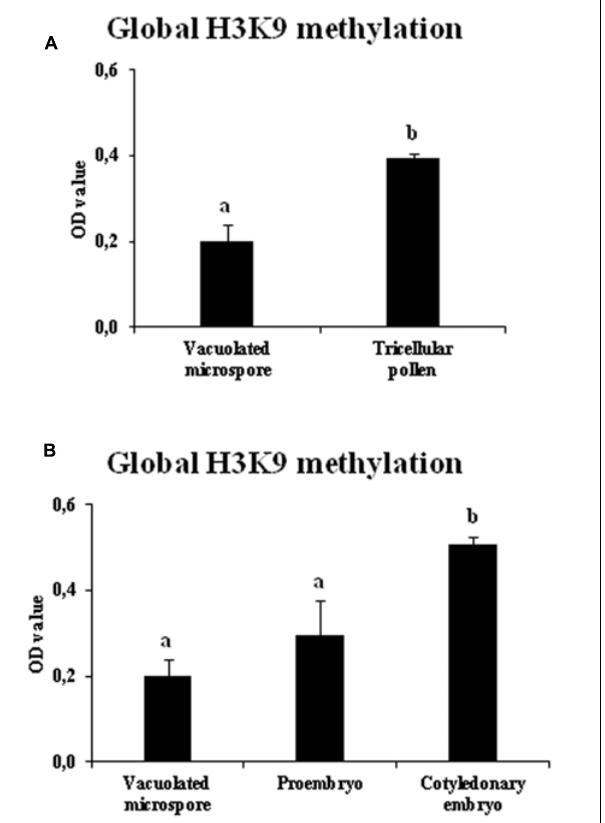
FIGURE 5 | Quantification of H3K9me2 immunofluorescence signal intensity during pollen development and microspore embryogenesis in Hordeum vulgare. Histograms represent the level of immunofluorescence intensity, in arbitrary units, as measured by ImageJ software tools over confocal maximum projections images, in different stages of the two microspore pathways, gametophytic development ( A : vacuolated microspore and tricellular pollen), and microspore embryogenesis ( B : vacuolated microspore, proembryo and coleoptilar embryo). Columns represent mean fluorescence intensity ( ± SEM). Different letters indicate significant differences according to ANOVA and Tukey’s test at p ≤ 0.05.